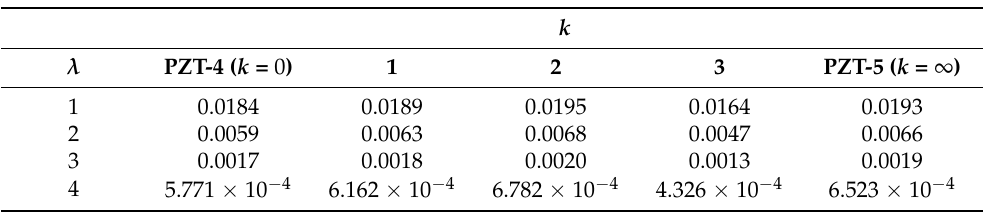
Table 4. Deflection values of central point of the plate with different gradient indexes k and length-to-